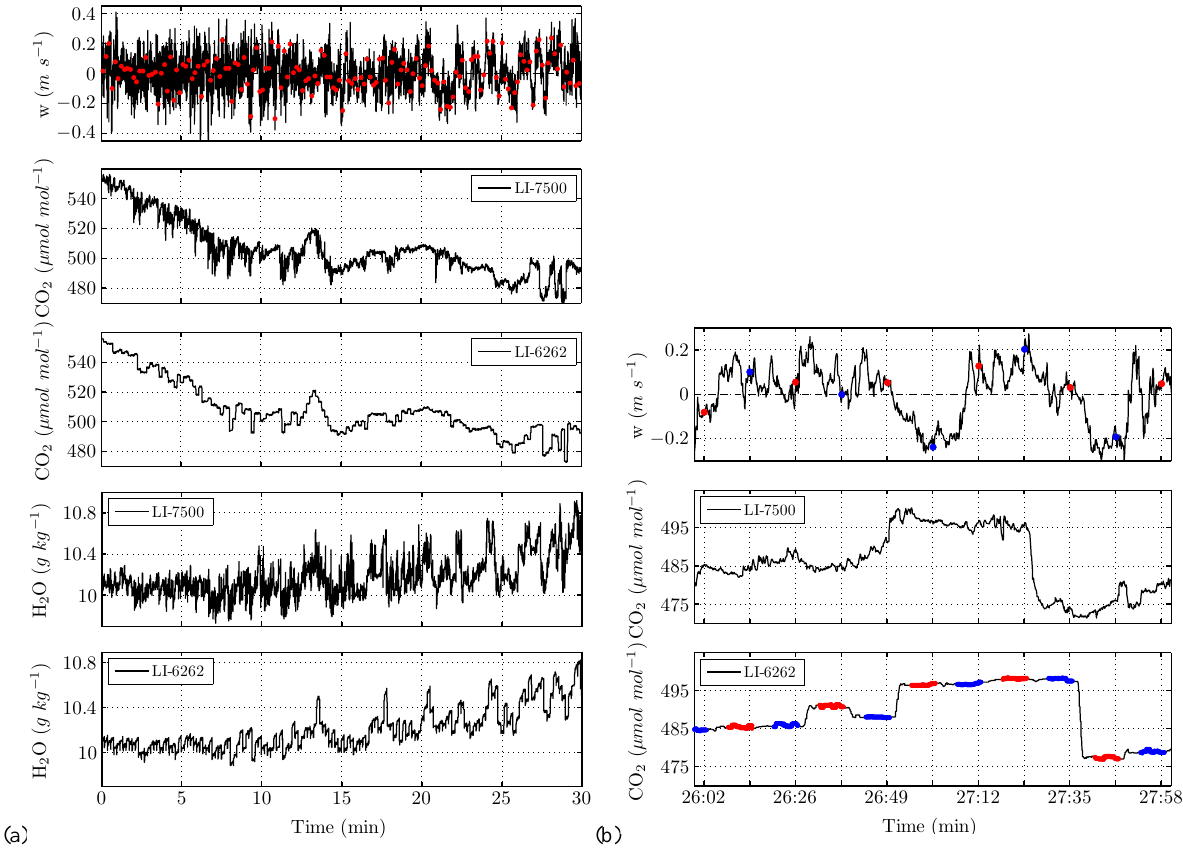
Fig. 6. (a) From top to bottom: 30-min time series of w (ms − 1 ) , open-path analyser CO 2 mixing ratio (µmolmol − 1 ) , closed-path analyser CO 2 mixing ratio (µmolmol − 1 ) , open-path analyser H 2 O mixing ratio (gkg − 1 ) and closed-path analyser H 2 O mixing ratio (gkg − 1 ) . Red dots are w-values averaged during the captures. (b) Same as above, but restricted to a 2-min period, and without the H 2 O signals. The colored parts on the CO 2 closed path measurements represent the data points used for mixing ratio estimates. The vertical dotted lines represent the sampling times, and the blue and red colors refer to the two